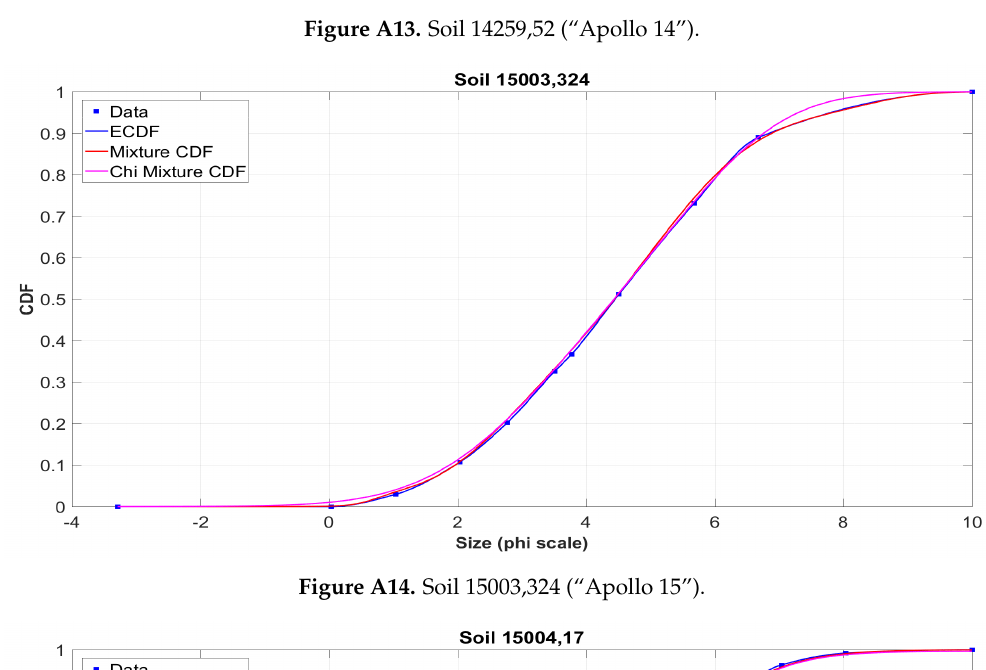
Figure A13. Soil 14259,52 (“Apollo 14”).